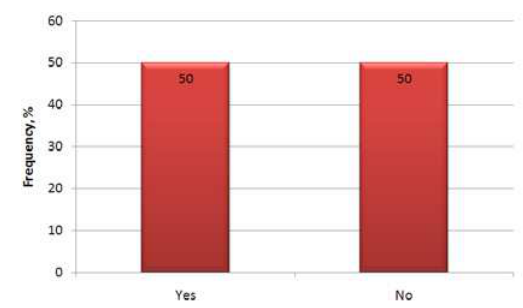
Fig. 11. Farmers’ access to information on prevailing mar- ket